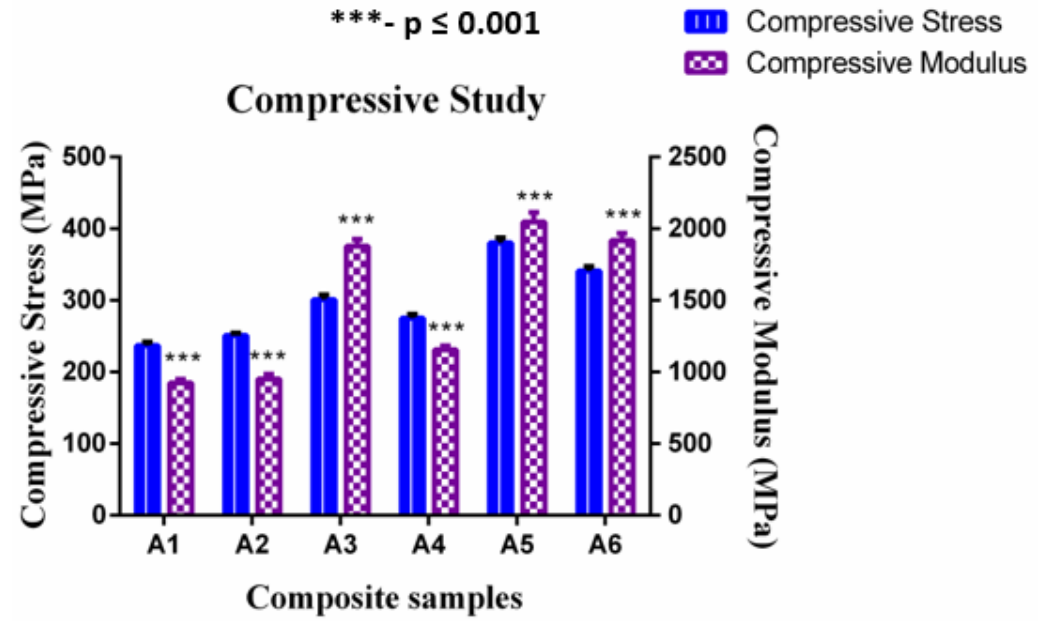
Figure 8. Compressive modulus vs. compressive strength of GF / SF / CTS composite sca ff olds. Data are represented as means of triplicate (n = 3) ± SD, where *** indicates p ≤ 0.001.